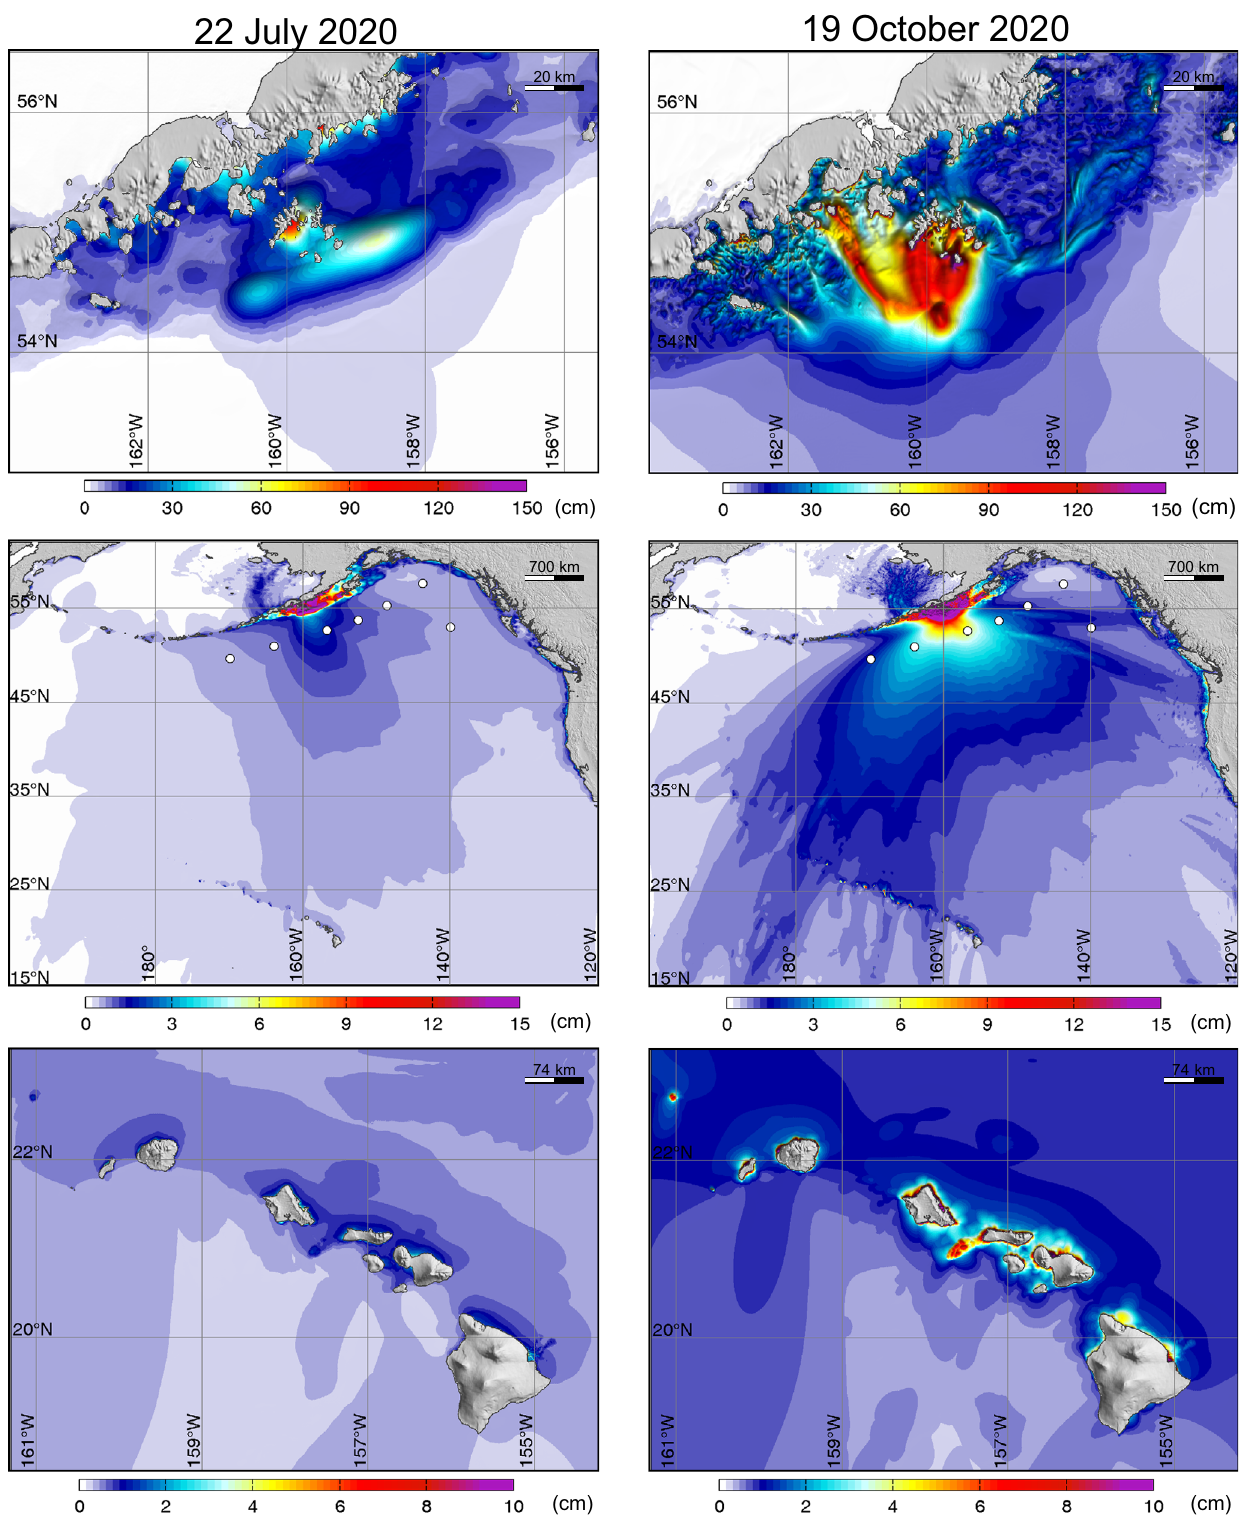
Fig. 9 | Comparison of the computed tsunami maximum sea elevation for the 22July2020and19October2020events. Computednear- fi eld(toprow)andfar- fi eld (middle and lower rows) tsunami wave amplitude for the 22 July 2020 M W 7.8